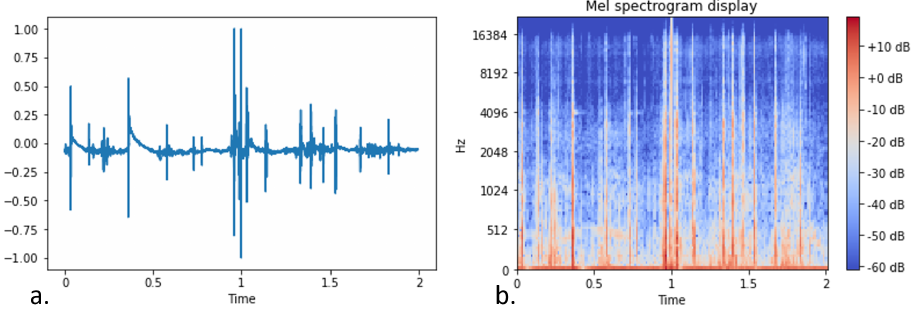
Figure 11. Raw representation ( a ) and log-scaled mel-spectrogram ( b ) of a dog not barking audio signal (dog